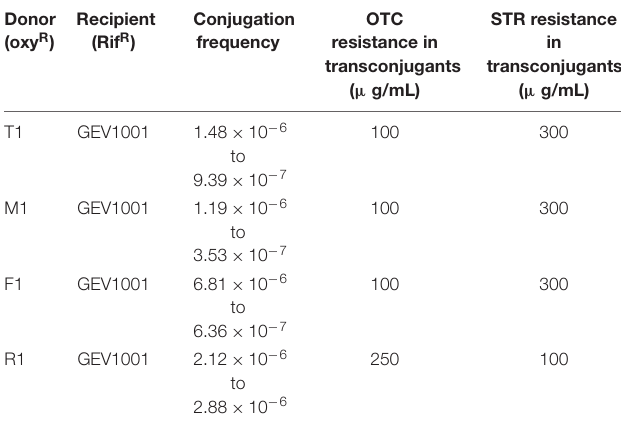
TABLE 4 | Conjugation frequencies per number of recipient cells for wild type mating assays. Donor Recipient (oxy R ) (Rif R )